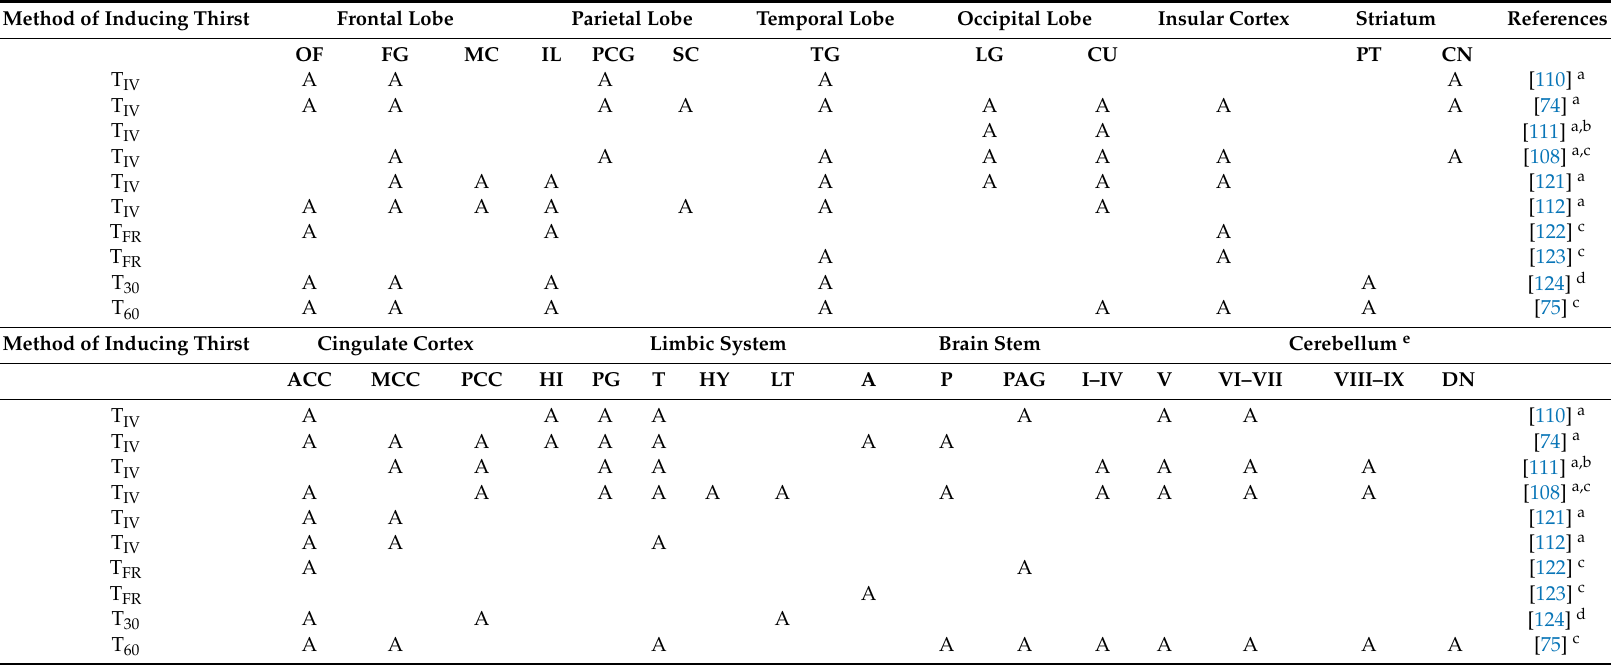
Table 2. Activation (A) of human brain regions and loci in response to experimentally induced thirst. Method of Inducing Thirst Frontal Lobe Parietal Lobe Temporal Lobe Occipital Lobe Insular Cortex